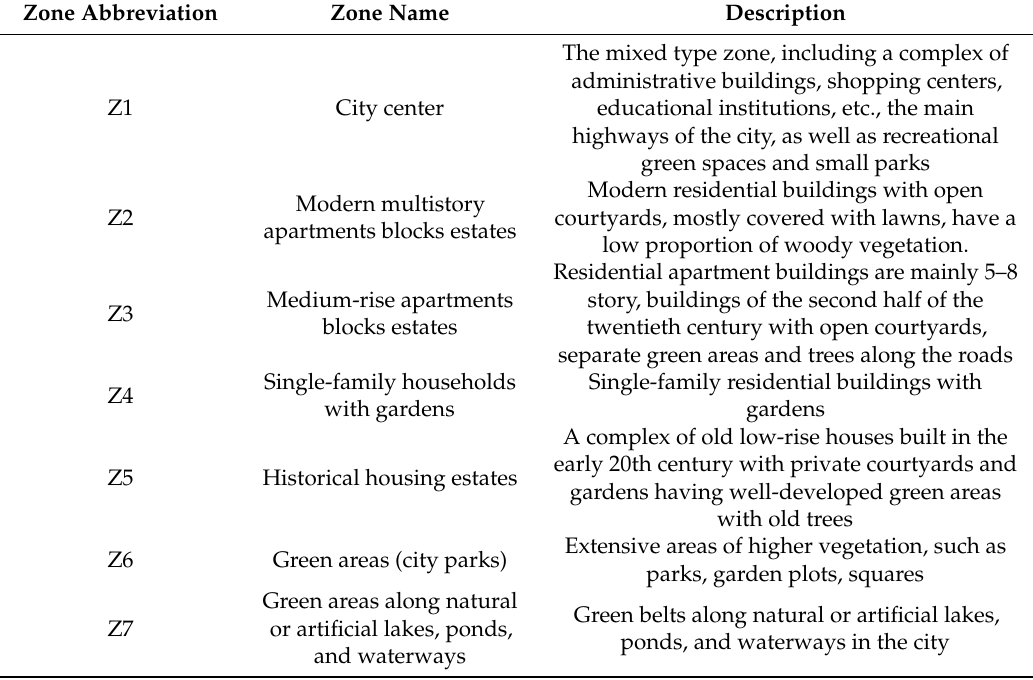
Table 4. Description of seven studied zones di ff ering by the level of human impact on the